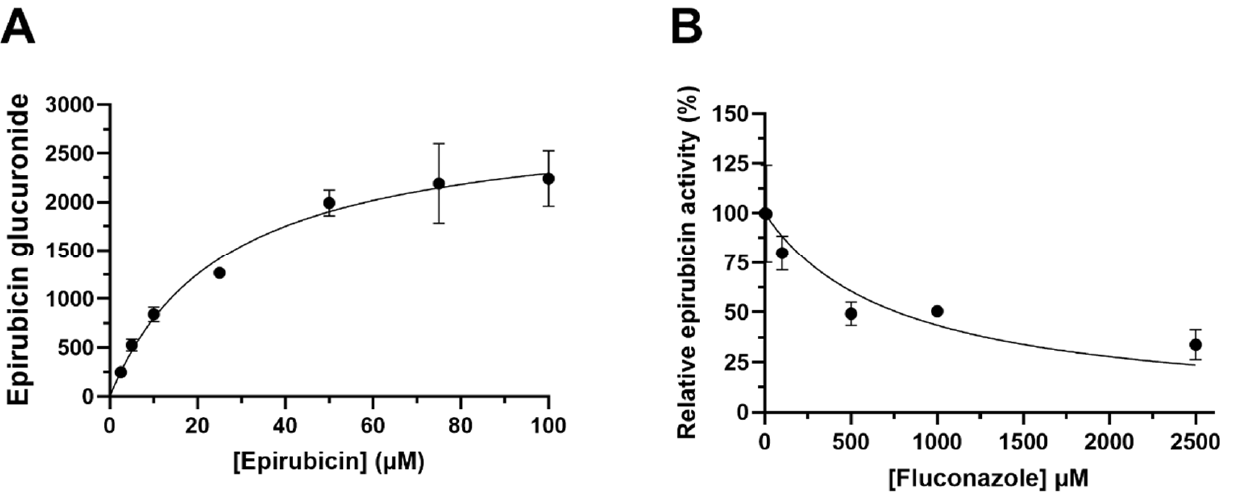
Figure 1. ( A ) Michaelis–Menten Kinetics of epirubicin by formation of epirubicin glucuronide in HLMs (R 2 = 0.96). Pooled HLMs (2 mg/mL) were incubated for 2 h with incremental amounts of epirubicin (between 2.5–100 µM) and epirubicin glucuronide was detected in the absence of stand- ards. ( B ) Normalised activity of epirubicin by inhibition of epirubicin glucuronide formation in HLMs. HLMs were incubated for 2 h with 25 µM epirubicin and increasing amounts of fl uconazole (between 10–2500 µM). Epirubicin glucuronide was detected, and response was measured relative to the control in the absence of fl uconazole. Mean peak area response ± S.D. is measured in arbitrary units. Data were generated in duplicate with standard deviation displayed by error bars.